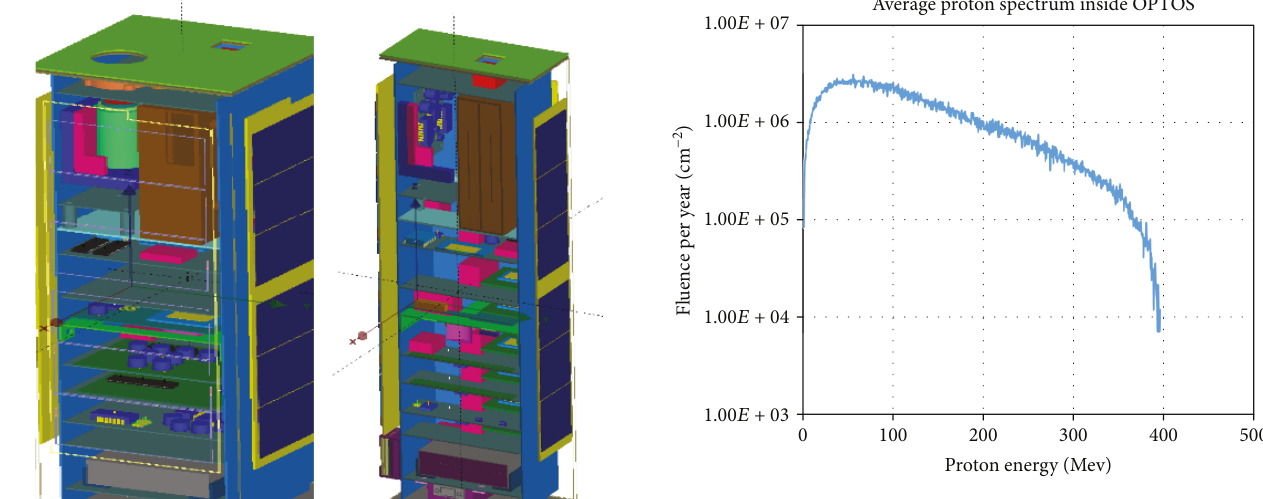
Figure 2: OPTOS 3D radiation model as built with FASTRAD